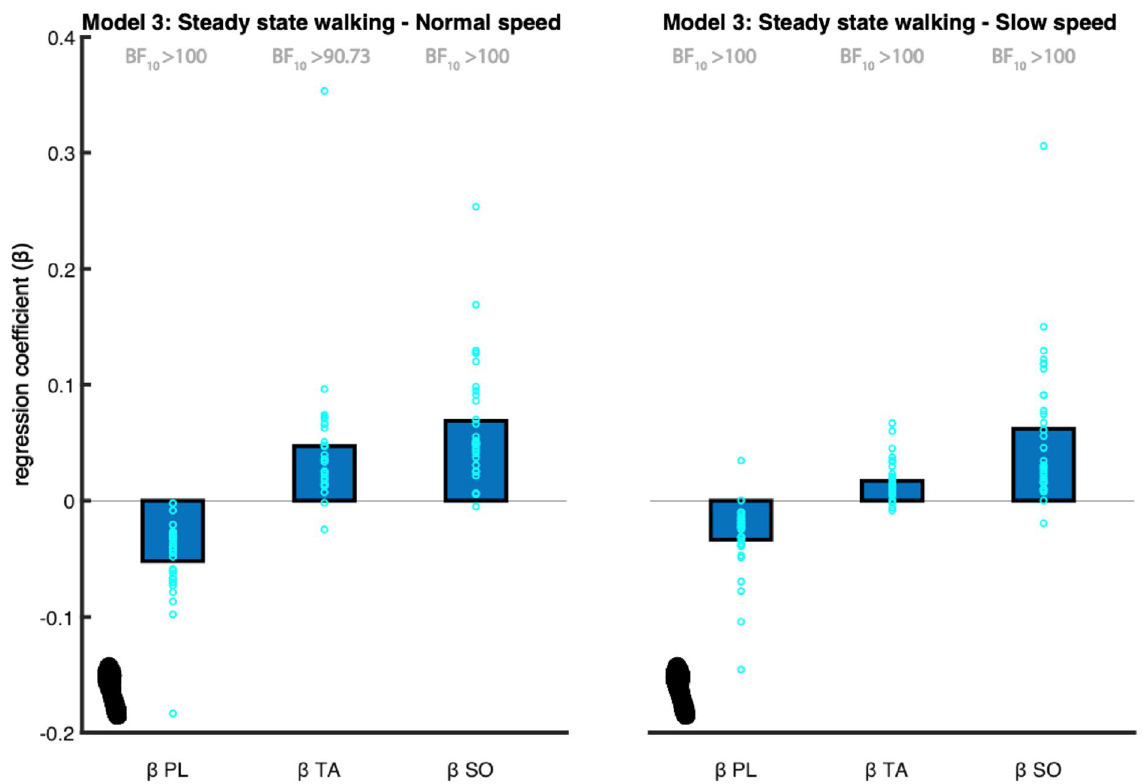
Figure 5. Mean regression coefficients of the muscle model (3). The predictors (β) are the peroneus longus (PL), tibialis anterior (TA) and soleus (SO) muscles’ activity. The foot print represents the steady-state walking condition (see Table 1). The light blue circles represent individual data points. The Bayes factors (BF 10 ) represent the degree of evidence supporting the regression coefficients to be different from zero. This figure was created using Matlab 2021a (https:// www. mathw orks. com/ produ cts/ matlab. html) and Adobe Illustrator CC 2018 (https:// www. adobe. com/ nl/ produ cts/ illus trator.